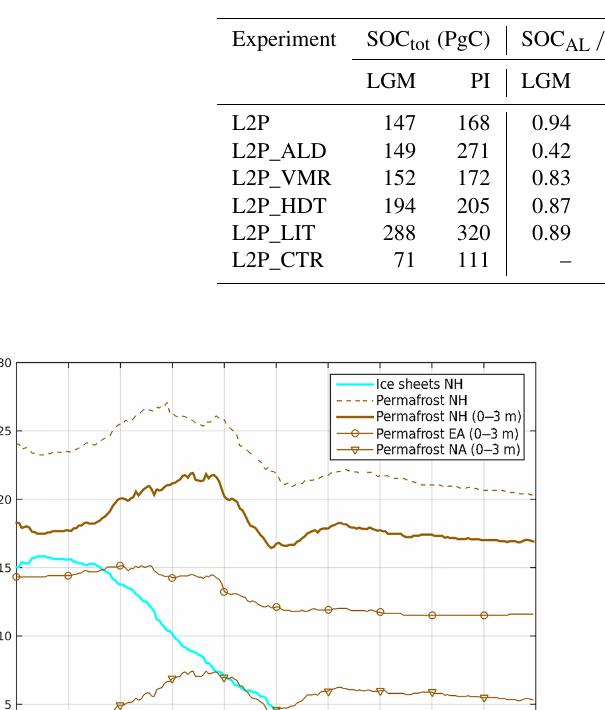
Table 2. Simulated SOC storage under LGM and PI conditions in near-surface permafrost soils for the standard parameter setting (L2P), reduced thermal conductivity of the organic layer (L2P_ALD), increased vertical soil mixing (L2P_VMR), increased slow pool lifetime (L2P_HDT), doubled litter input (L2P_LIT), and a control run without transfer of SOC to permafrost (L2P_CTR). Storages are expressed as totals, as the ratio between active layer and permafrost carbon, and normalized by the near-surface permafrost area (PFA).